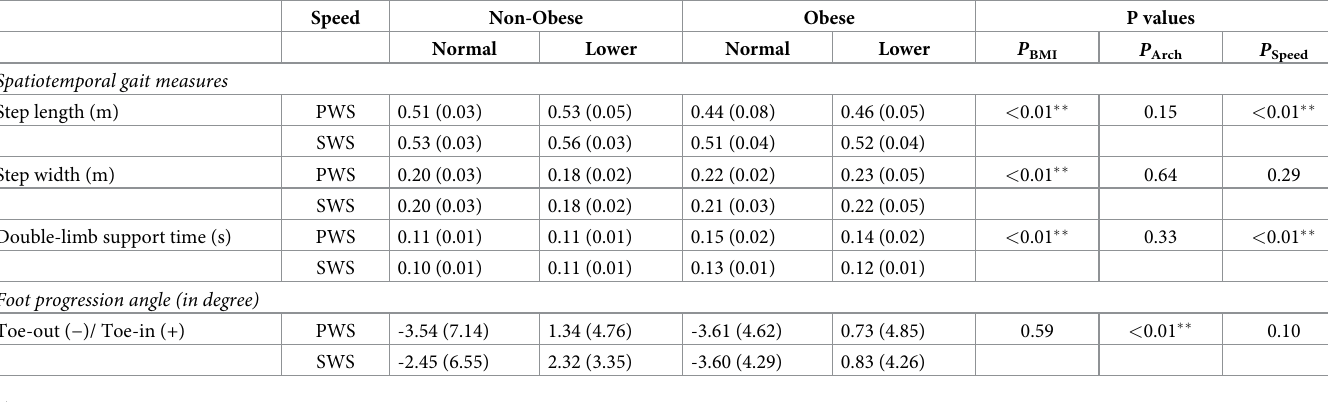
Table 2. Means (standard deviations) for spatiotemporal gait parameters and foot progression angle during walking at each participant’s preferred walking speed (PWS) and pedestrian standard walking speed (SWS), 1.25 m/s, across BMI (non-obese and obese) and arch (normal arch and lower arch) groups. Statistical results using three-way mixed ANOVA are also shown ( P BMI : P values of BMI effect; P Arch : P values of arch height effect; P Speed : P values of speed effect).